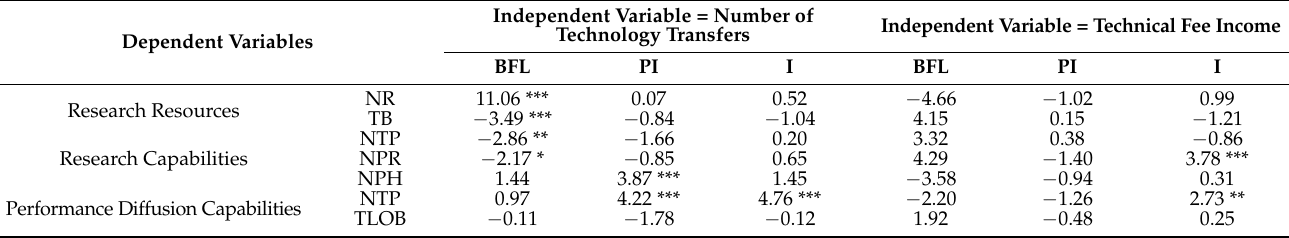
Table 10. The results of panel analysis by GRI mission type